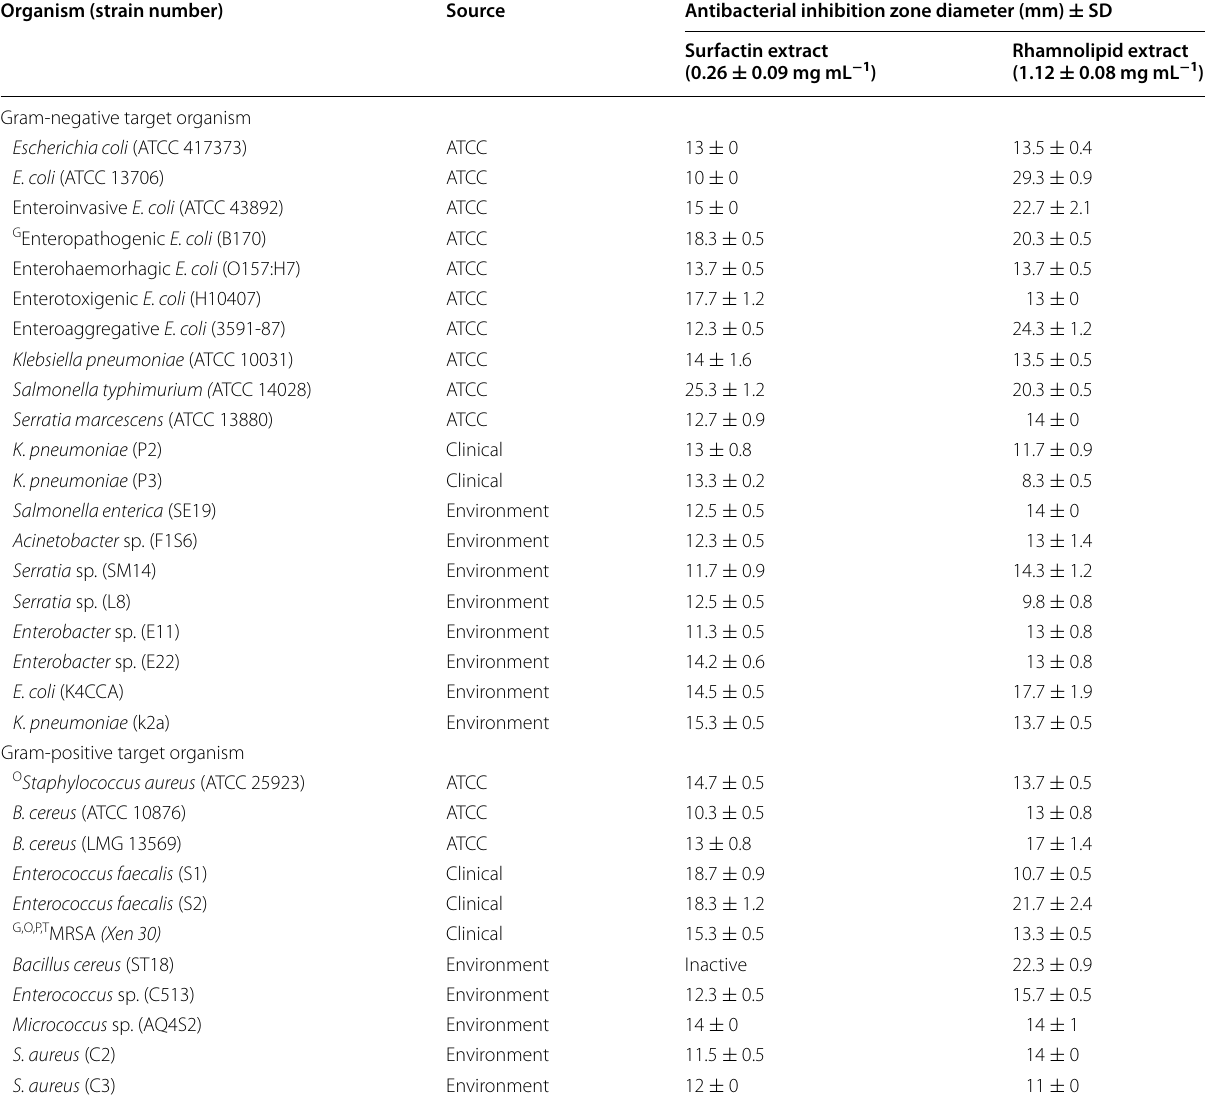
Table 1 Antibacterial activity of the biosurfactant extracts (1.00 mg mL − 1 ) against a panel of Gram-negative and Gram- positive bacterial